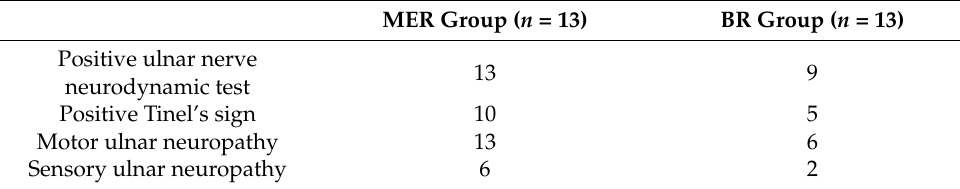
Table 3. Clinical diagnosis for ulnar